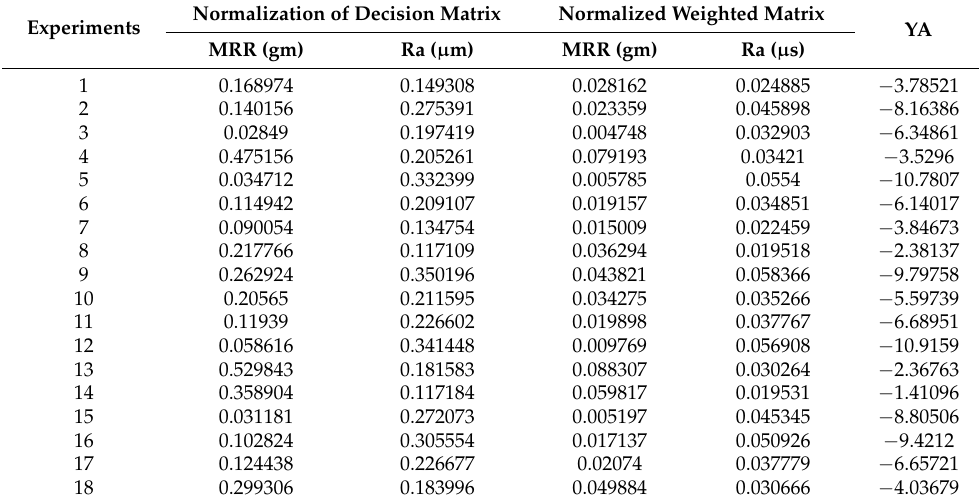
Table 5. Normalized decision and weighted